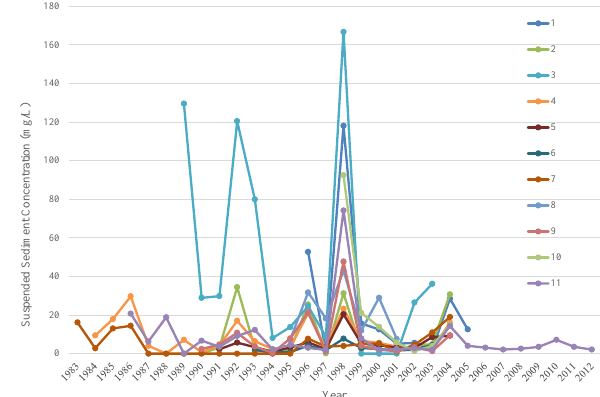
Fig. 3: Comparison of annual suspended sediment load (Ton/ha) from different monitoring stations Figure 3. Comparison of annual suspended sediment load (tha − 1 ) from different monitoring stations. PLS has been shown to work well under these constraints (Abdi, 2010; Nash and Chaloud, 2002). PLS extracts orthog- onal factors (latent variables), requiring these latent variables to explain as much of the covariance between measured re- sponse (SS) and predictors (landscape variables) as possi- ble. This is followed by regression of predictors on response (Helland, 1988; Höskuldsson, 1988). Predictor coefficients (magnitude and direction) from the PLS regression can de- fine the role and influence of predictor variables on response. Magnitude of the coefficient indicates the weight and degree to which the predictor influenced the response; direction of influence is “ + ” for an increase in the coefficient and “ − ” for a